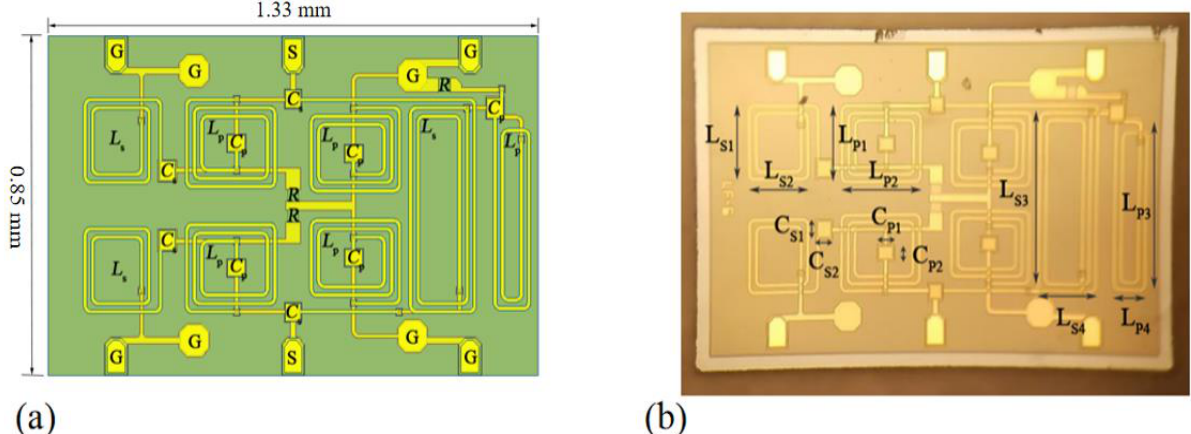
Figure 3. Images of the modelled and fabricated reflectionless band-pass filter, based on GaAs IPD process. ( a ) Plane structure of electromagnetic field model of proposed band-pass filter based on GaAs IPD process. ( b ) Microscope image of fabricated reflectionless band-pass filter, based on GaAs IPD process. Table 2. Component size of reflectionless band-pass filter based on GaAs IPD process (Unit: μm).